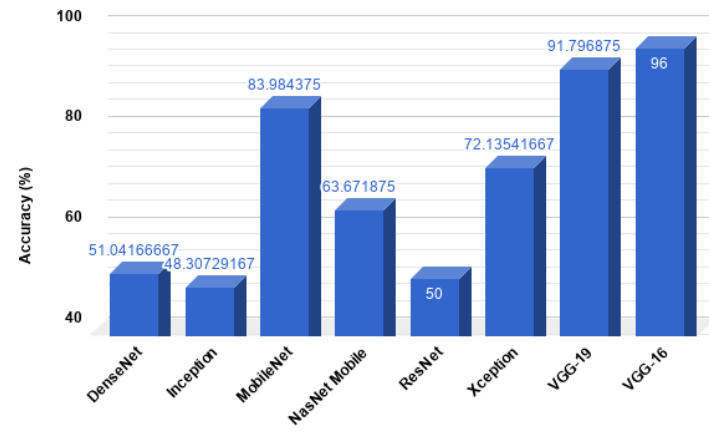
Figure 15. In our CNN | Xfer module, VGG-16 performs best accuracy-wise, followed by VGG-19.